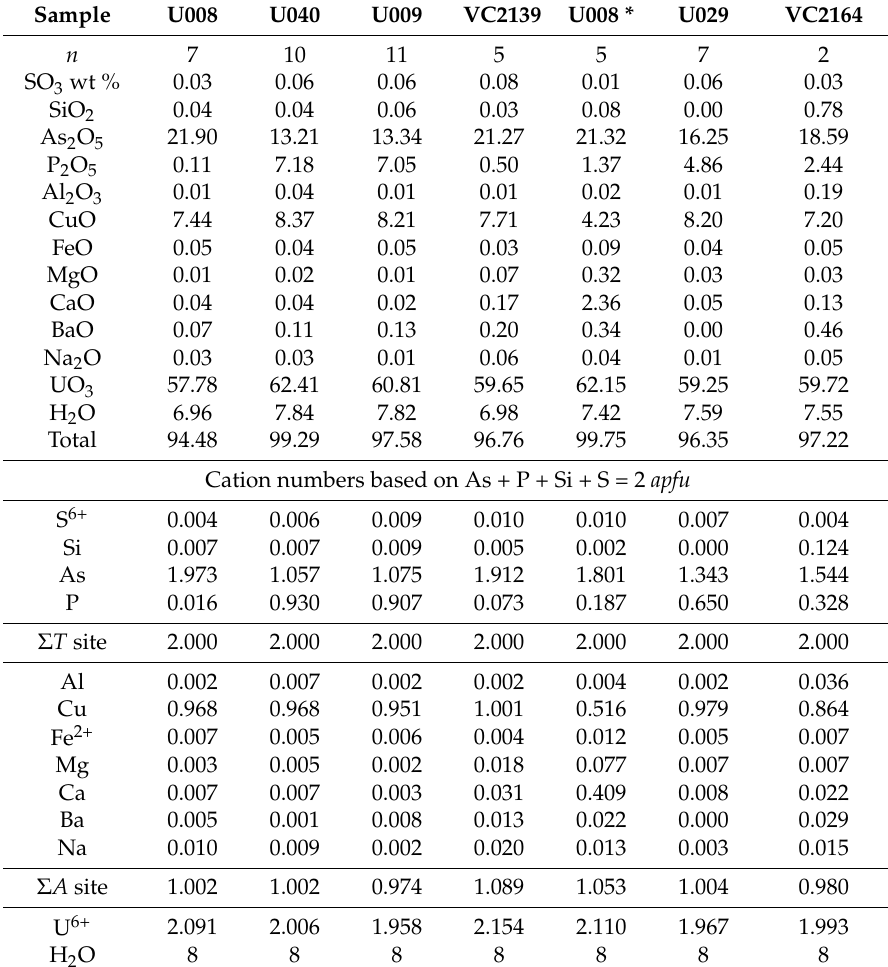
Table 2. Chemical composition of metazeunerite.